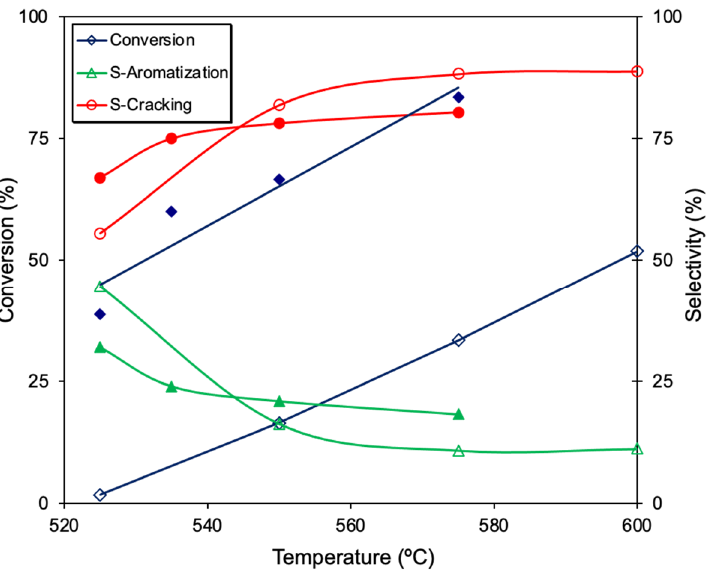
Figure 1. Conversion and products distribution obtained with W (opened symbols) and Mo (closed symbols) prepared as doped carbon xerogels at 500 °C (adapted from ref. [27]).